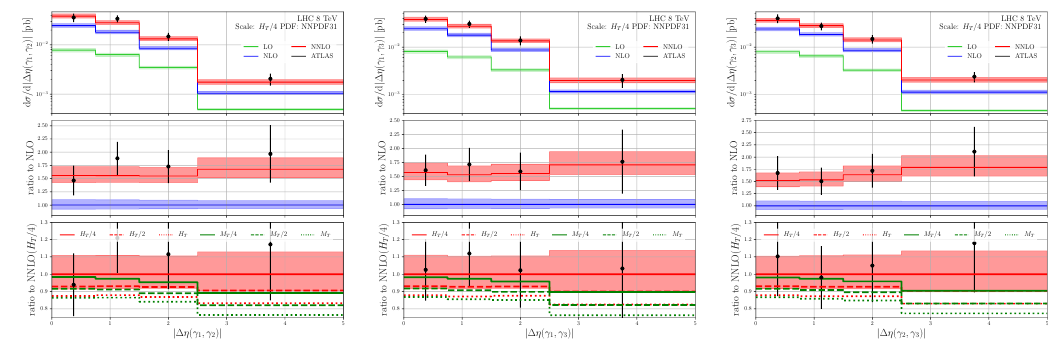
Figure 4 . As in (cid:12)gure 2 but for the